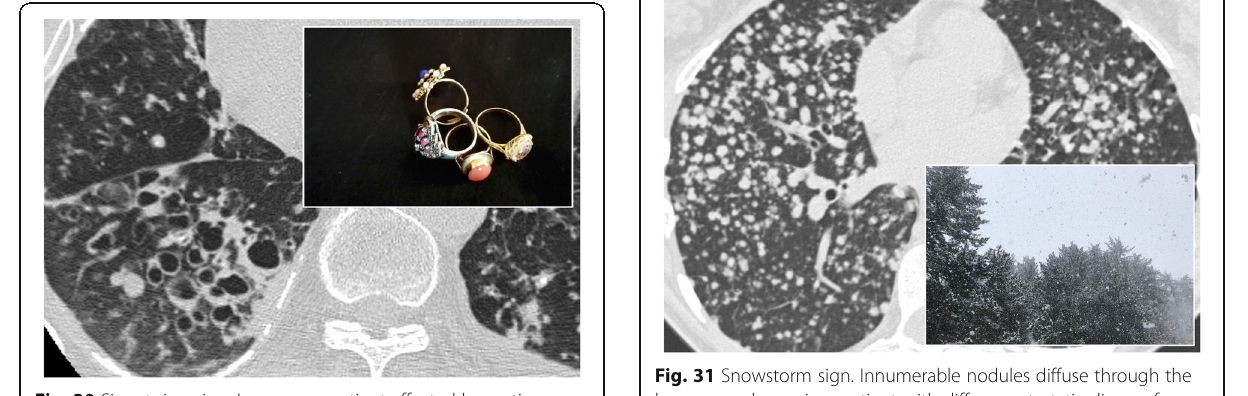
Fig. 30 Signet ring sign. In a young patient affected by cystic fibrosis, multiple air-filled bronchiectasis are flanked by respective pulmonary vessels: this appearance reproduces the so-called signet ring sign